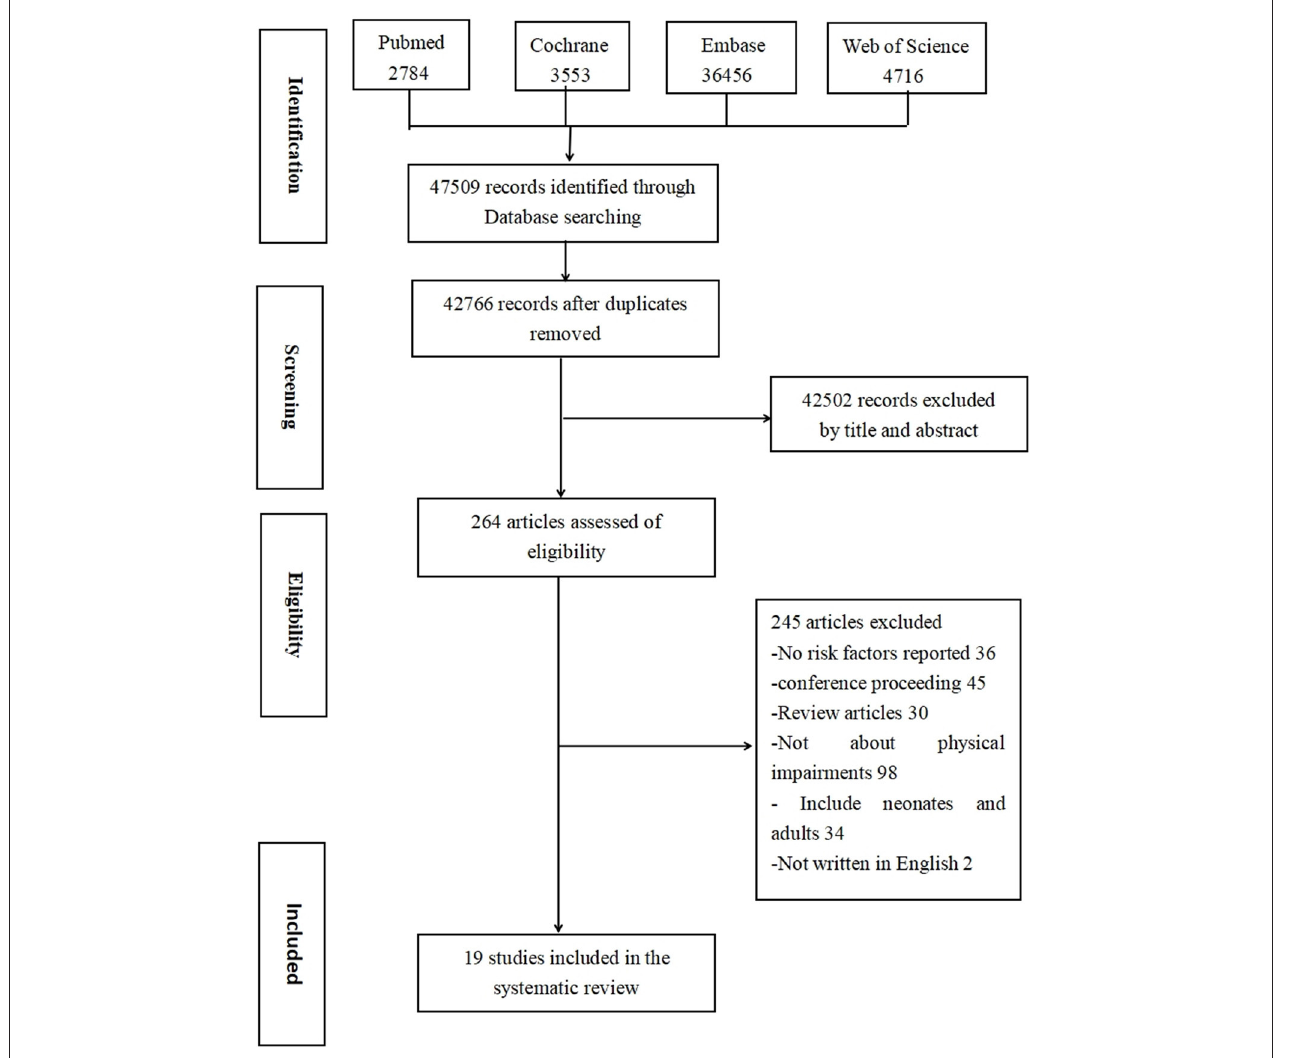
FIGURE 1 | Flow diagram of study